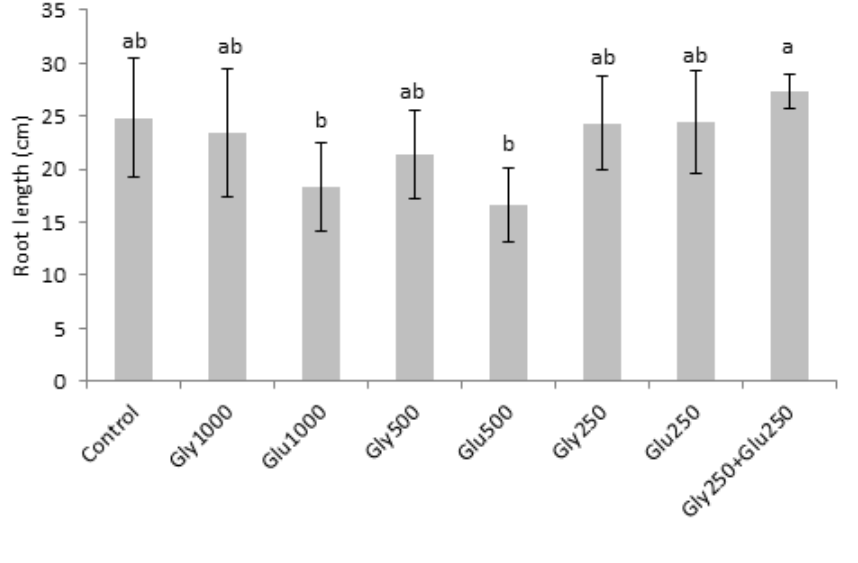
Figure 2: Overall root length of lettuce under foliar application of glycine and glutamine amino acids. Data are average of four replications ± SD; comparison of means was done at 5% level of Duncan multiple ranges